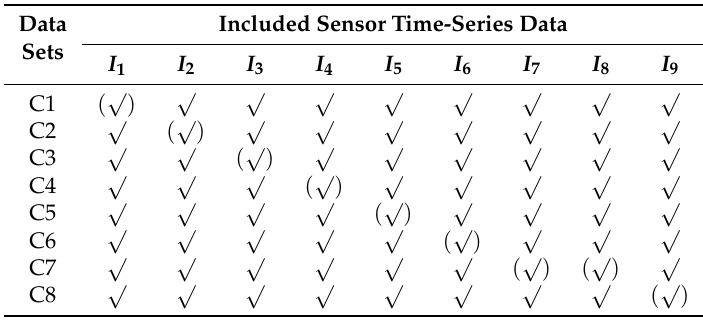
Table 3. Sensor time-series data included in eight prepared